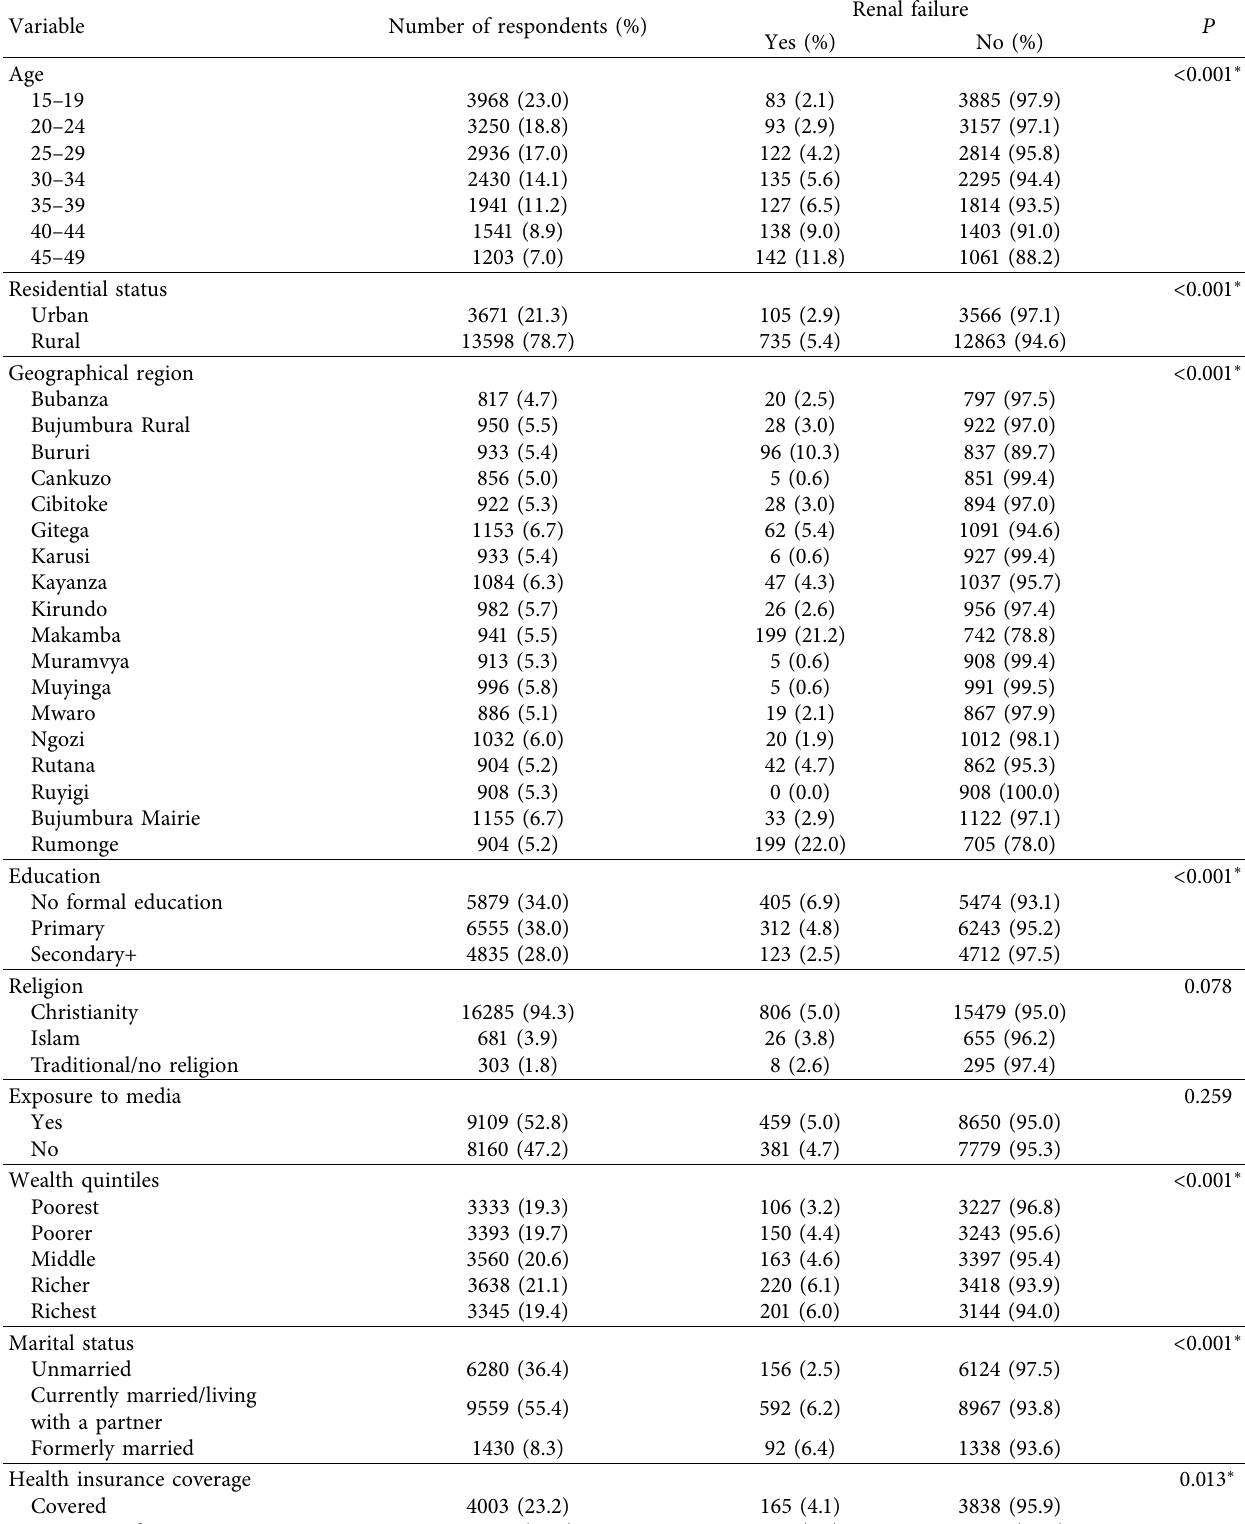
Table 1: Sociodemographic characteristics of respondents and the distribution of renal failure ( n �